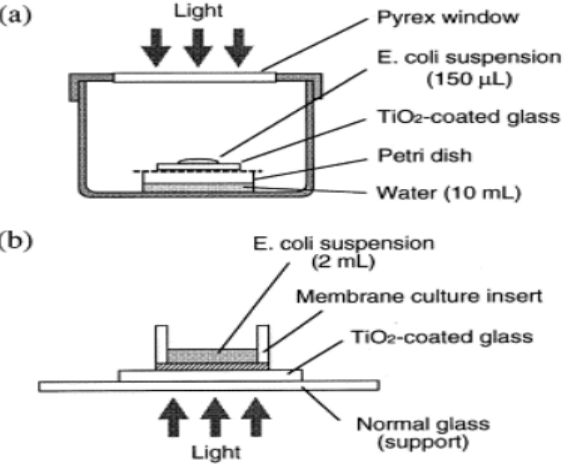
Figure 5. ( a ) Liquid-film photocatalytic system and ( b ) membrane-separated system. Reprinted from [59], Copyright (1997), with permission from Elsevier.